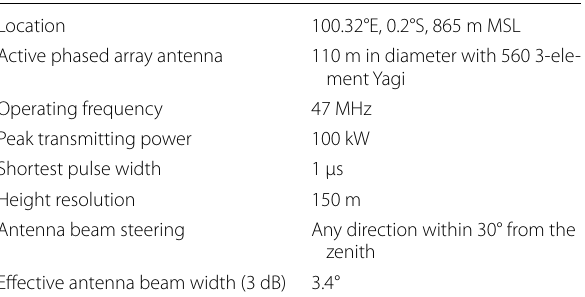
Table 1 Specification of the equatorial atmosphere